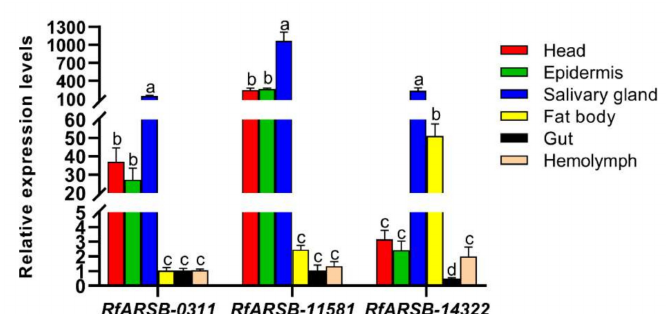
Figure 2. Gene expression profiles of RfARSBs across di ff erent tissues / organs in R. ferrugineus larvae. Expression levels were normalized to the GAPDH reference gene. Data are shown as the mean ± standard error (SE) from five independent biological repetitions. Di ff erent lowercase letters above the bar indicate statistically significant di ff erences among di ff erent tissues / organs for the same gene at p < 0.05 (one-way analysis of variance (ANOVA) followed by Tukey’s honestly significant di ff erence (HSD) multiple comparisons).